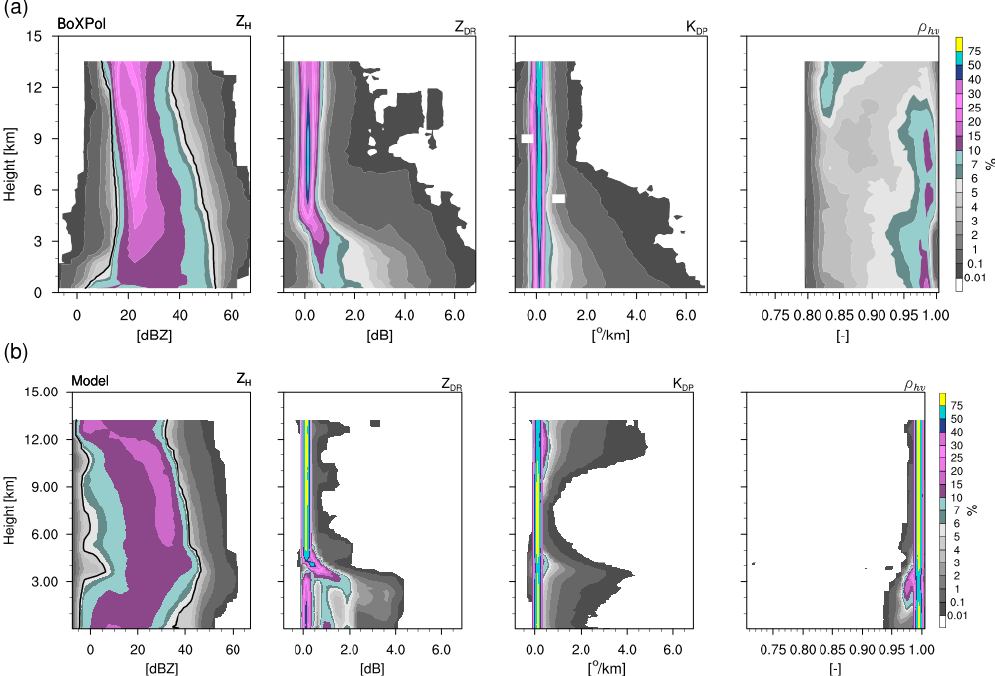
Figure 10. CFADs of horizontal reflectivity and differential reflectivity, specifically, the differential phase and cross-correlation coefficient from 14:45 to 15:30UTC on 5 July 2015. CFADs from the model are shown for five ensemble